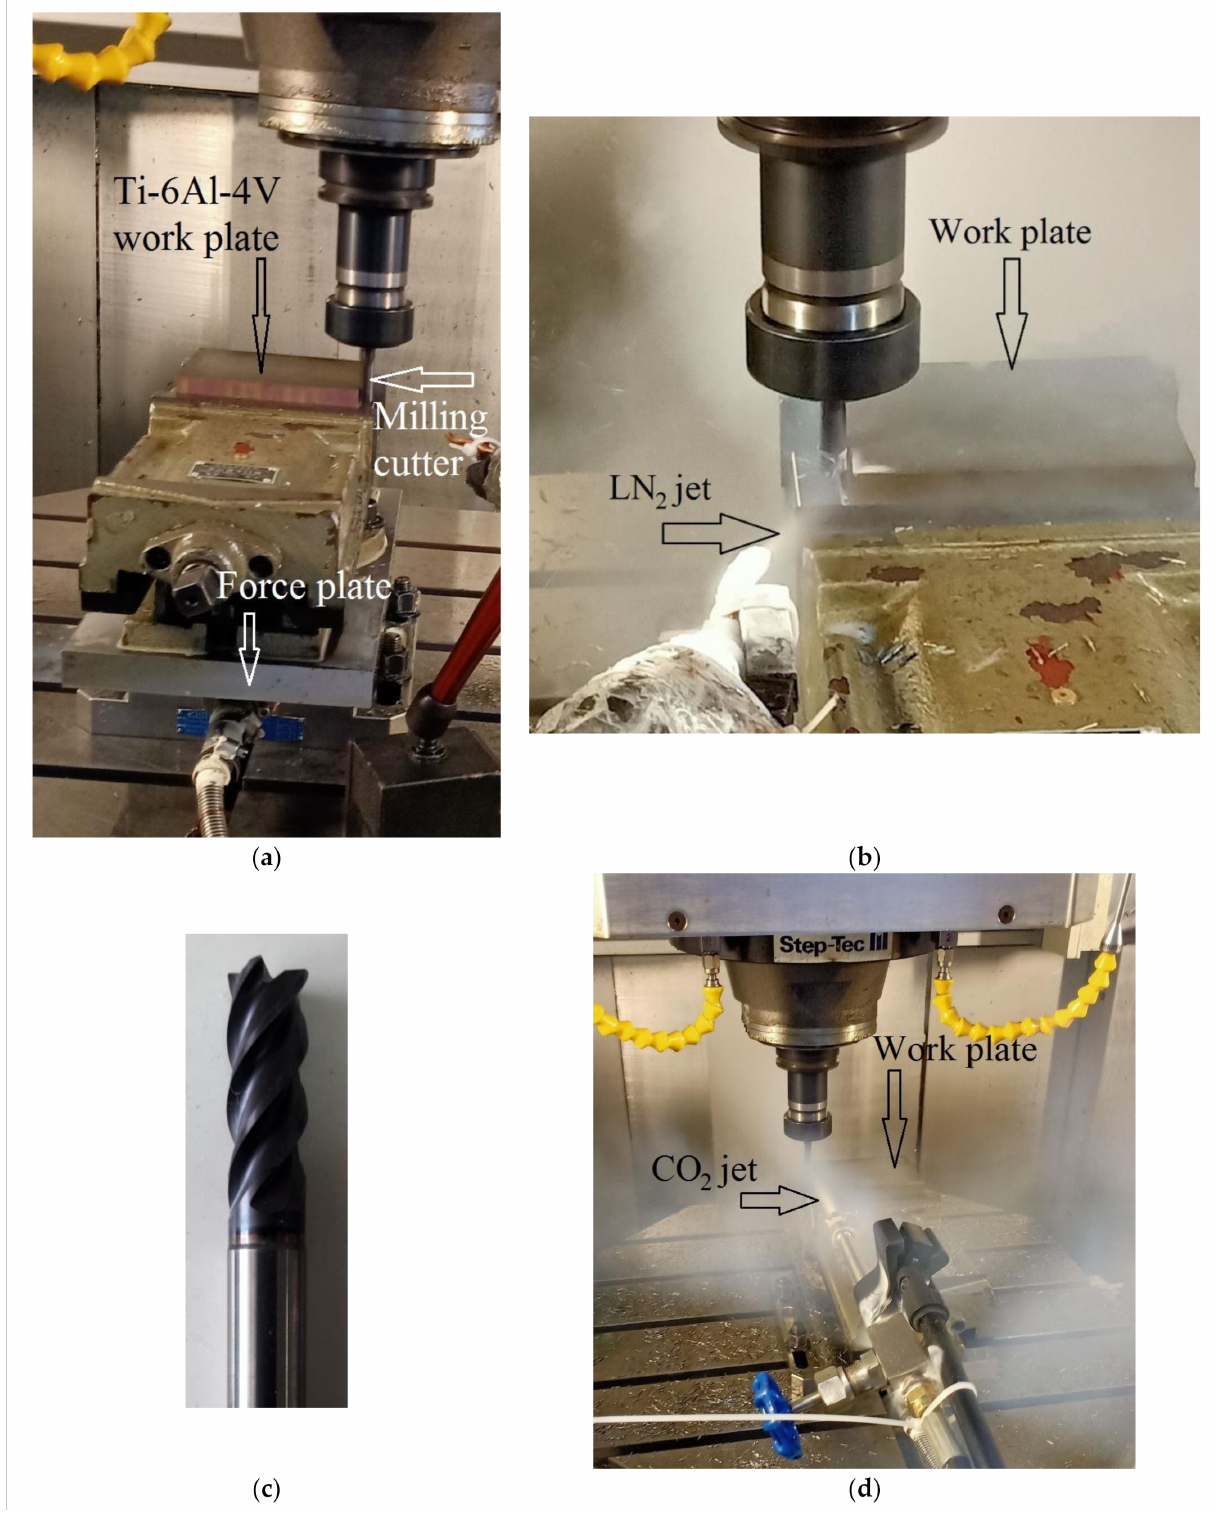
Figure 1. The experimental setup: ( a ) the work plate, cutter, and force plate; ( b ) milling under evaporative cryogenic cooling; ( c ) the side- and end-mill cutter used in the experiments; and ( d ) milling under throttle cryogenic